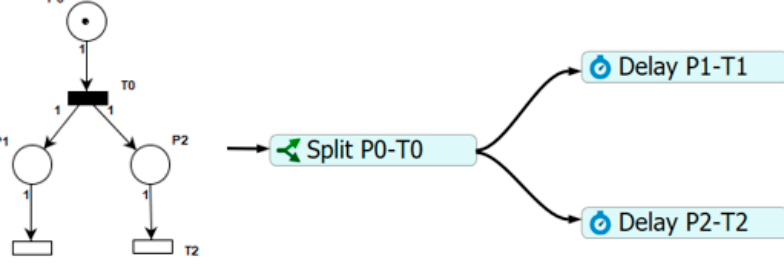
Figure 10. Concurrency with temporal entities in FlexSim.